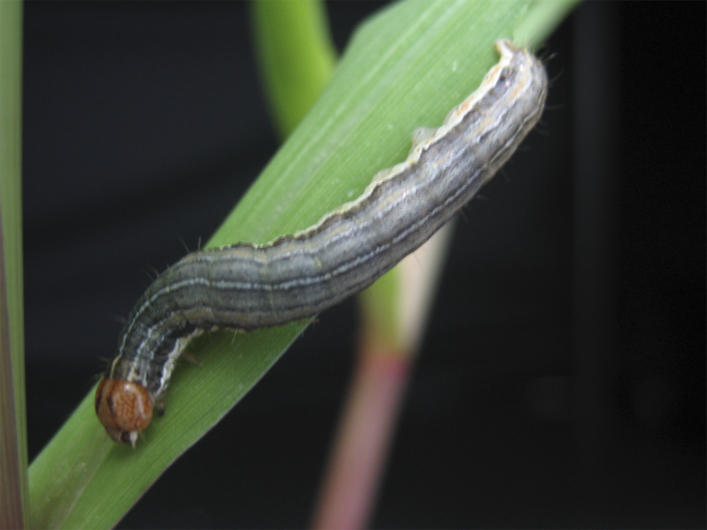
Plant volatiles released by corn plants may help the caterpillar
M. separata avoid predators.